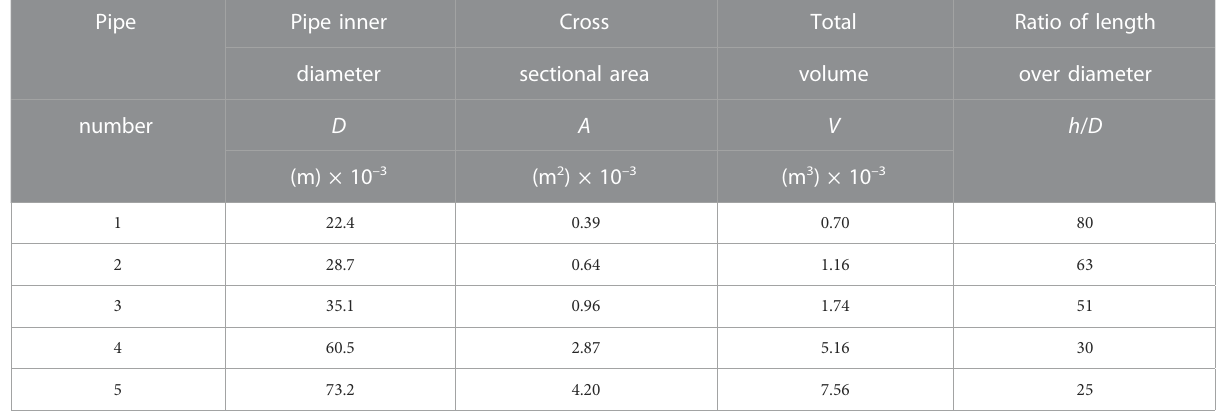
TABLE 1 Dimensions of the vertical pipes.